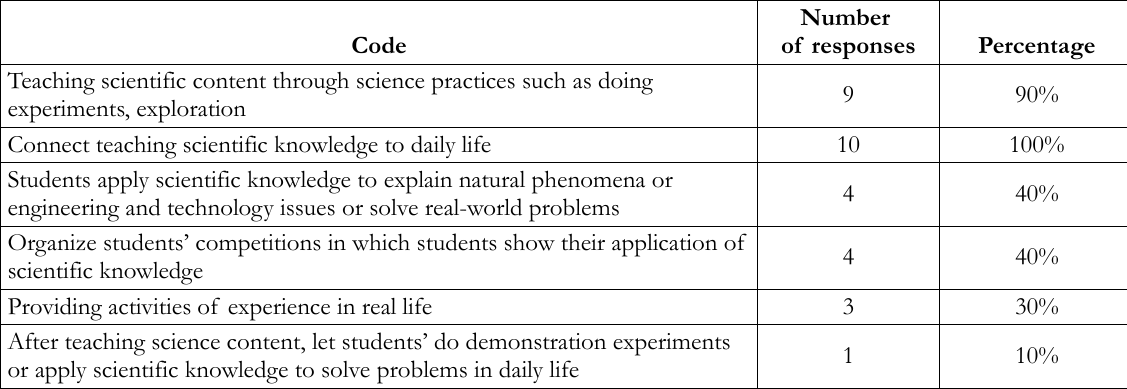
Table 8. Views about teaching science of school